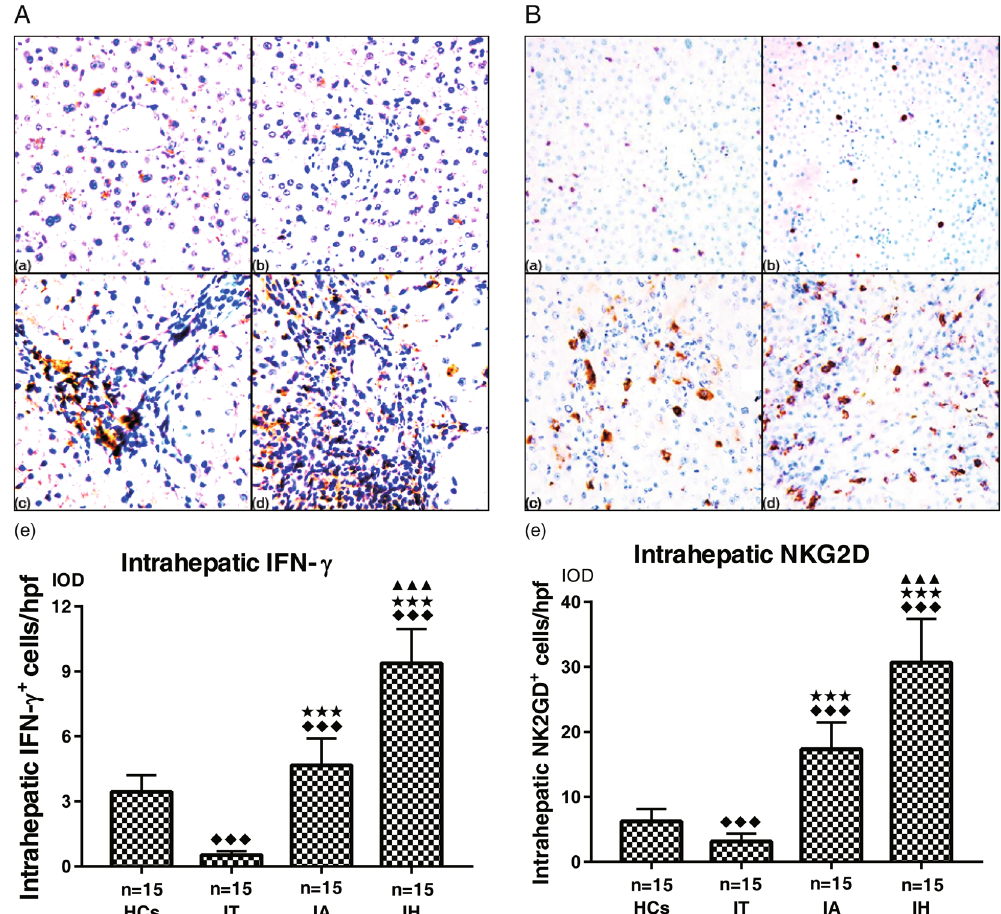
Figure 3. Representative graphs of intrahepatic IFN- γ + cells (A, 200 × ) and NKG2D + cells (B, 200 × ) expressions. ( a ) HCs, healthy controls, ( b ) IT, chronic HBV carriers, ( c ) IA, CHB patients, ( d ) IH, HBV- ACLF patients. ( e ) Collective analysis of results from all 4 groups. IFN- γ + cells were distributed mainly in the inflammatory sites and periportal areas that were infiltrated with lymphocytes. NKG2D + cells were mainly distributed in Disse’s space of hepatic lobule in HCs and chronic HBV carriers, and mainly in periportal areas in CHB and HBV-ACLF group. Nemenyi test following Kruskal-Wallis H test were used for comparing intrahepatic IFN- γ + and NKG2D + cells expressions between two groups. Compared with HCs group, ◆◆◆ P < 0.01; Compared with IT group, ★★★ P < 0.01; Compared with IA group, ▲▲▲ P <